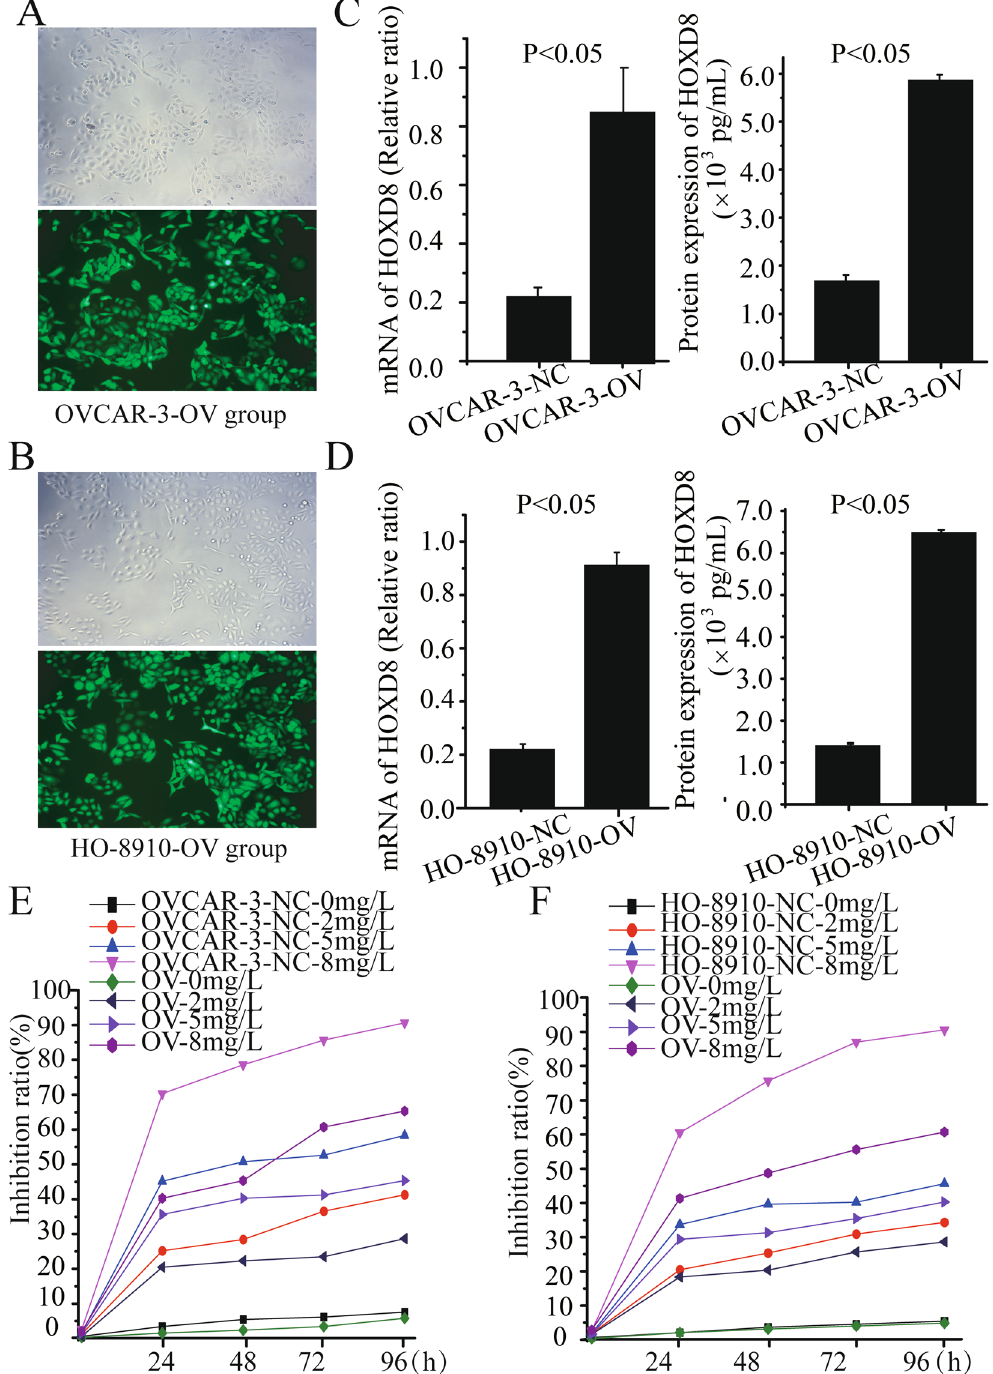
Figure 7. Overexpression of HOXD8 enhancing the cisplatin-resistance in ovarian cancer. After infecting with lentivirus mediated HOXD8 or control vectors (NC group), the ovarian cancer OVCAR-3 and HO-8910 cells were observed by optical microscope and fluorescence microscopic with a magnification of 400 ( A , B ). Expression of HOXD8 mRNA and protein were significantly up-regulated in OVCAR-3-OV cell ( C ) and HO-8910-OV cells ( D ). Cellular proliferation of OVCAR-3-NC and OVCAR-3-OV, HO-8910-NC and HO- 8910-OV were detected by MTT assay ( E , F